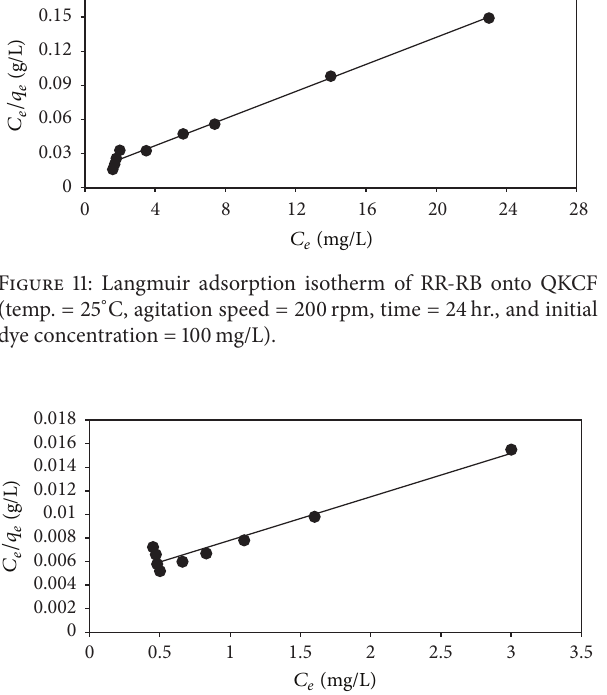
Figure 12: Langmuir adsorption isotherm of RB-5 onto QKCF (temp. = 25 ∘ C, agitation speed = 200 rpm, time = 24 hr., and initial dye concentration =